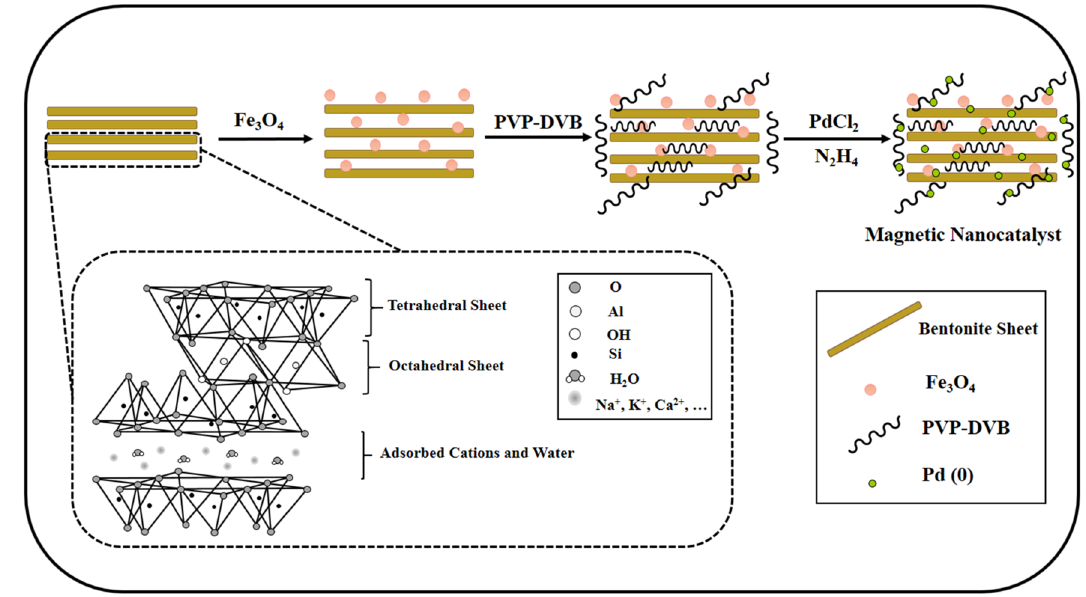
Figure 1. Schematic of preparation of Fe-Ben/PVP-DVB/Pd nanocatalyst.